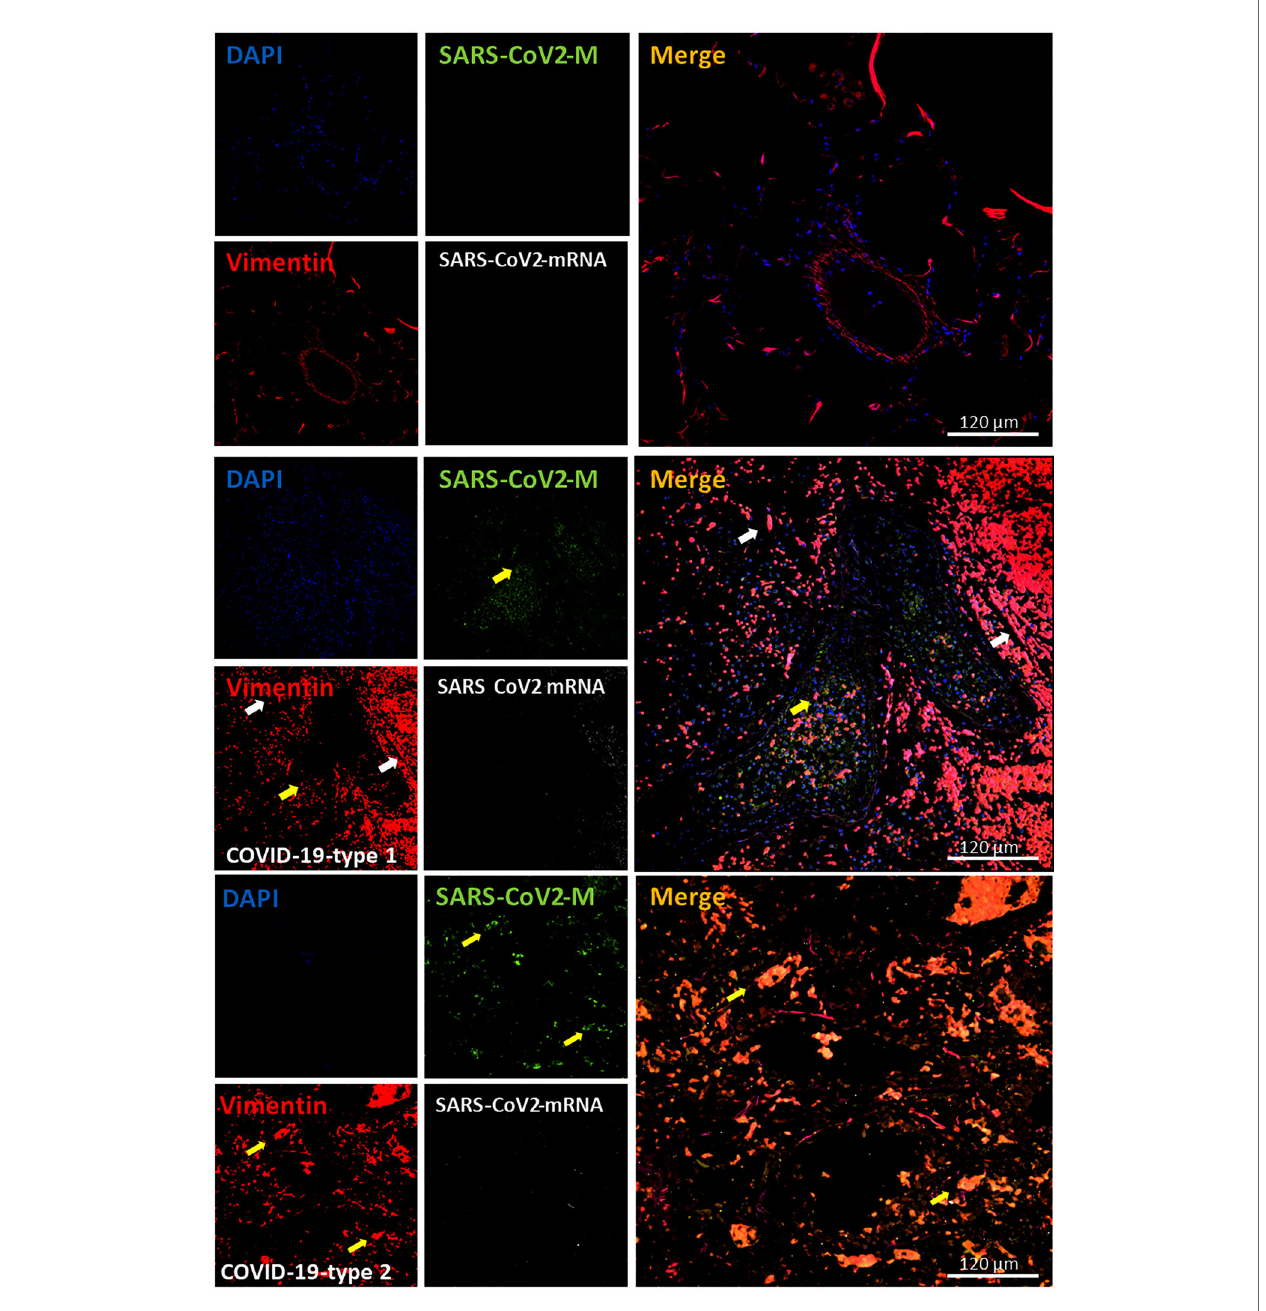
FIGURE 9 | COVID-19 disease induces an exacerbated proliferation of fi broblast. Staining for nuclei (DAPI, blue staining), SARS-CoV-2 protein M (SARS-CoV-2-M, green staining), vimentin (Vimentin, red staining), and SARS-CoV-2-mRNA (White staining) was performed. 3D reconstructions of lung samples collected from uninfected (control) and COVID-19 (Type 1 or 2, enhanced coagulation and immune in fi ltration phenotype). In control conditions, vimentin-positive cells are located at the alveolar wall base, and around large blood vessels with no unspeci fi c viral protein or mRNA staining were found as expected (Control). In contrast, in the enhanced coagulation phenotype (COVID-19, type I, damage), a large amount of staining widely distributed in the lung was observed (COVID-19-type 1). Again, most viral protein M was concentrated inside blood vessels. Also, a small population of vimentin-positive cells is positive for viral mRNA (see white arrows). Further, a small population of vimentin cells was positive for SARS-CoV-2 protein M without viral mRNA (yellow arrows). We observed a signi fi cant proliferation of vimentin- positive cells in all samples and areas analyzed in the immune in fi ltration phenotype (n = 13-15 different cases analyzed with a least fi ve sections